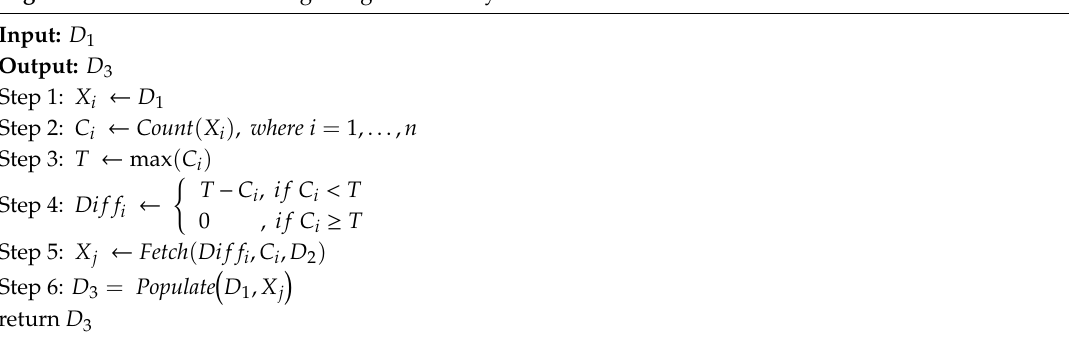
Algorithm 1. Dataset balancing using a secondary dataset